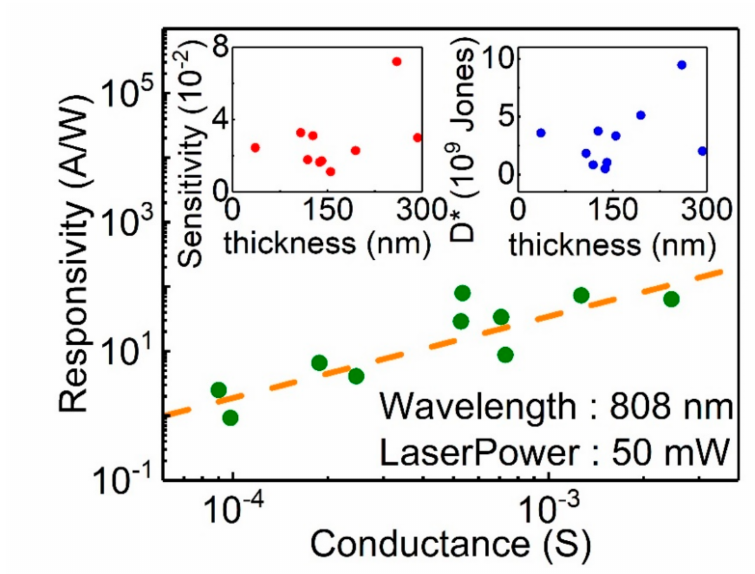
Figure 6. The responsivity is proportional to the conductance of the flake. The top-left inset shows that the responsivity is insensitive to the flake thickness. The top-right inset shows that the detectivity is insensitive to the flake